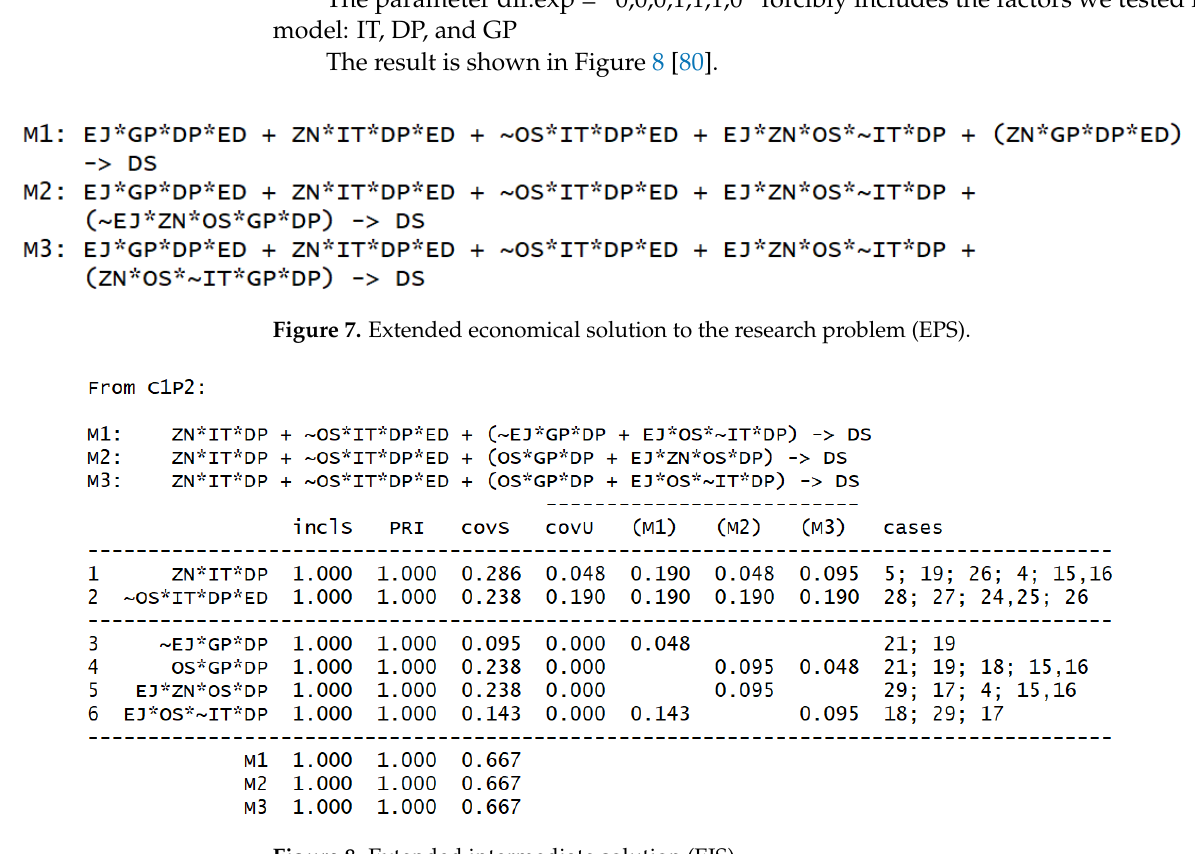
Table 2. Indicators of multivariate statistical analysis (performed by the authors, 2021).